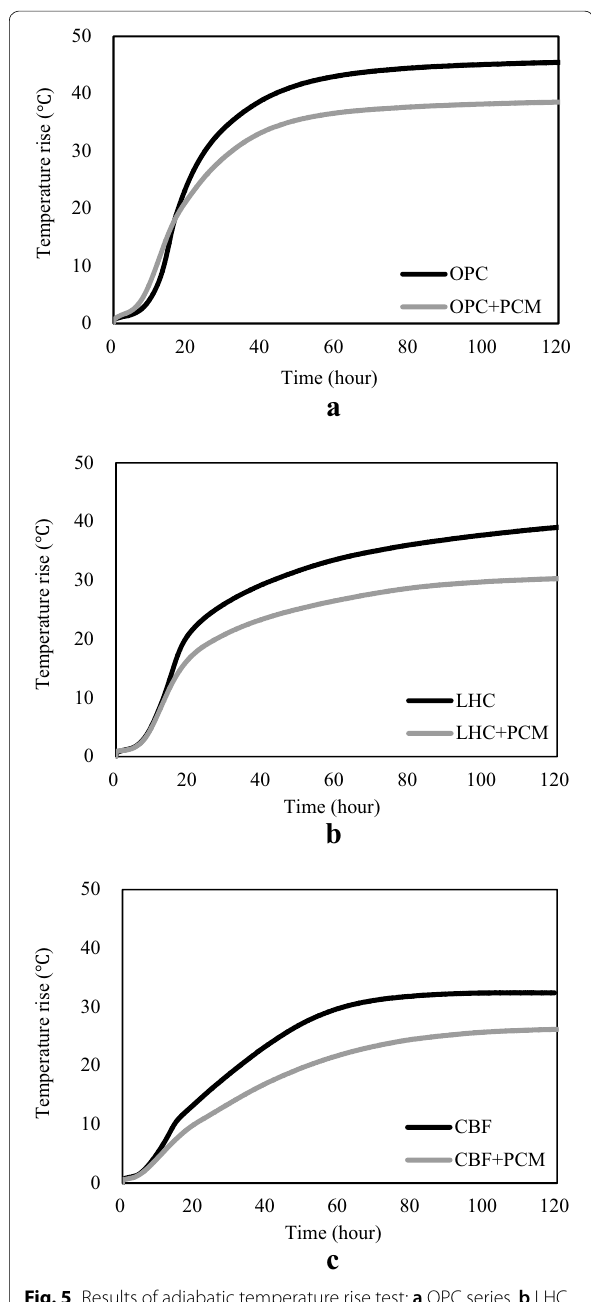
Fig. 5 Results of adiabatic temperature rise test; a OPC series, b LHC series, c CBF